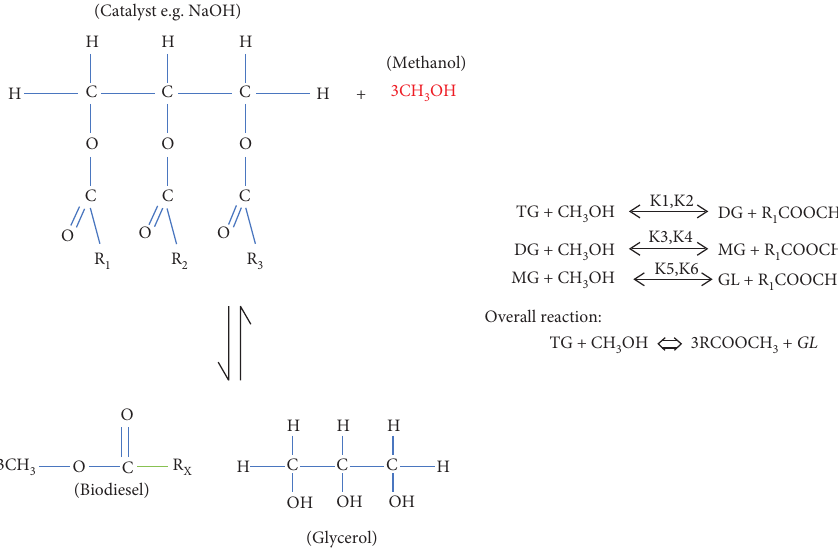
Figure 2: Biodiesel production